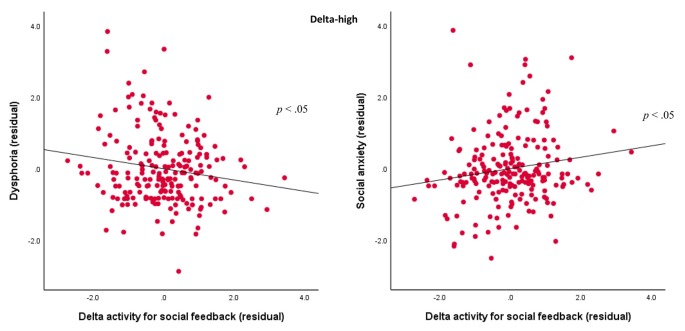
Associations between TF2SF1 (delta-high activity) for social feedback and symptoms. Scatterplots displaying the associations between delta-high activity for social feedback (difference between correct and incorrect trials) residual with dysphoria (left) and social anxiety (right) residuals.